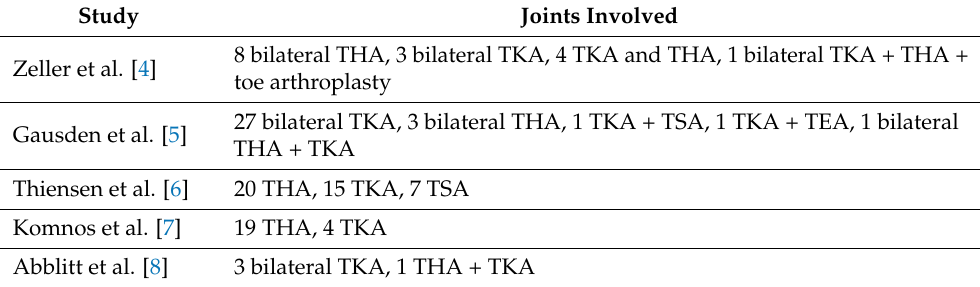
Table 3. Joints involved.